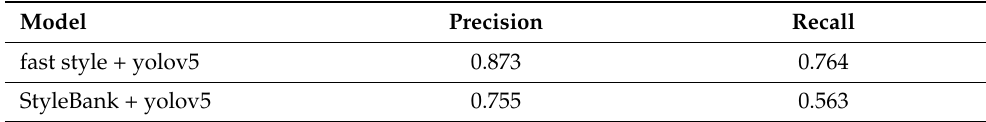
Table 11. Detection result for 2 style